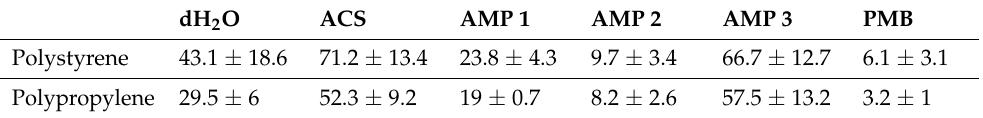
Figure 8. OD measurements at 405 nm (Y-axis) of free hemoglobin in a 1% human erythrocyte solution incubated with PBS, dH 2 O, ACS, Triton X-100, SDS, Tween, AMPs 1, 2, or 3 (100 µ M), or polymyxin B (100 µ M) for 60 min at 37 ◦ C in polystyrene (black bars) or polypropylene (red bars) tubes. Average values from three experimental replicates, each containing two technical replicates, are presented with error bars (SD) included in plots. Significantly different data as defined from paired t -test is indicated by asterisks (ns: non-significant). Table 7. Calculated hemolysis ratios according to Equation (1) for dH 2 O, ACS, AMPs 1, 2, and 3 (100 µ M) or polymyxin B (PMB–100 µ M) from measurements at 405 nm on 1% washed human erythrocytes incubated in polystyrene or polypropylene tubes. Measurements from samples with 10% Triton X-100 (positive control) and PBS (negative control) were used as 100% and 0% hemolysis for the normalization. Normalization was performed on data averaged from three experimental replicates, each containing two technical